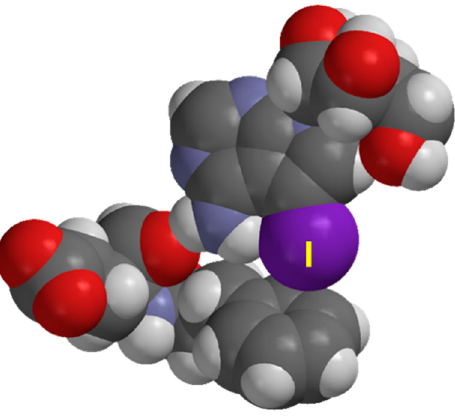
Figure 5. Space-filling model of close contact between 5-iTU and truncated receptor residues (Phe605 and Glu606) of PDB 6G34.